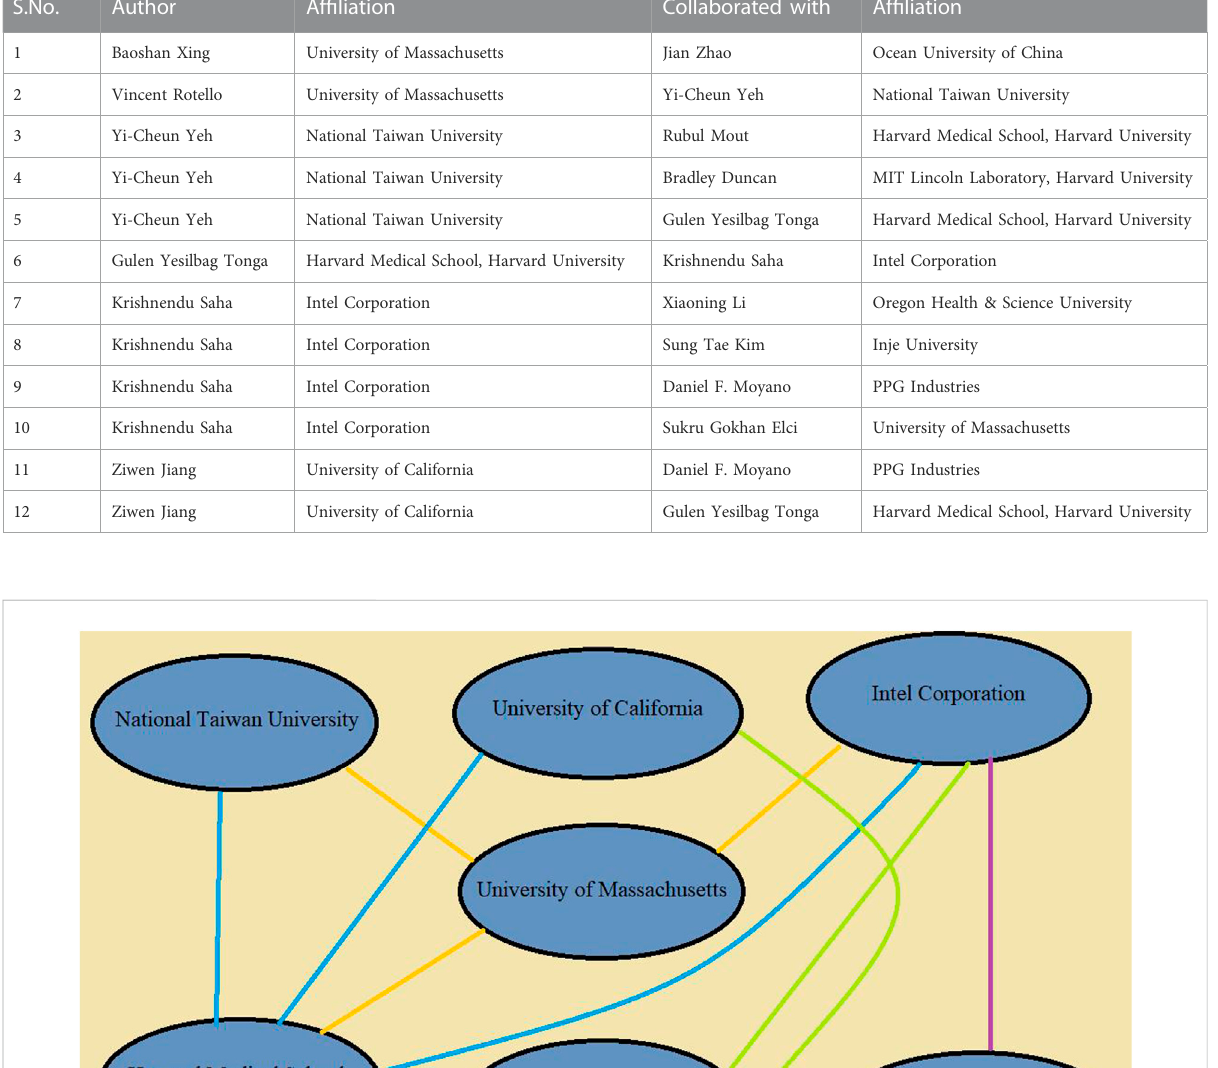
TABLE 4 Details of groups working on cancer therapy using nanoparticles. S.No.